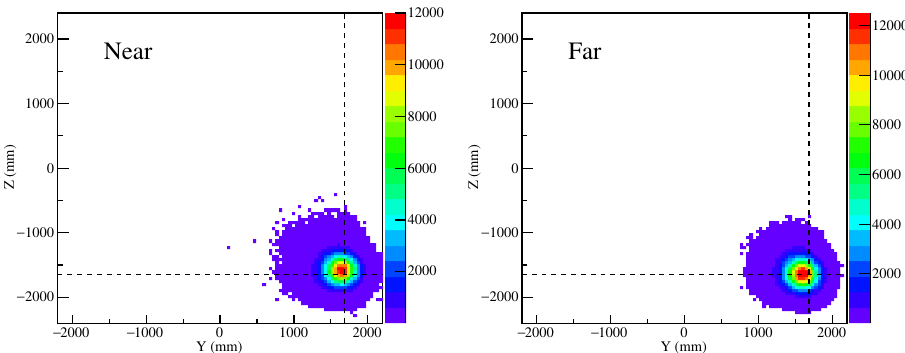
Figure 2 . Reconstructed vertices of 60 Co source in GC. The RENO uses Cartesian coordinates of (x, y, z), and the detector center is (0,0,0). The point crossed by the black dashed lines is an actual position of the source location in the GC